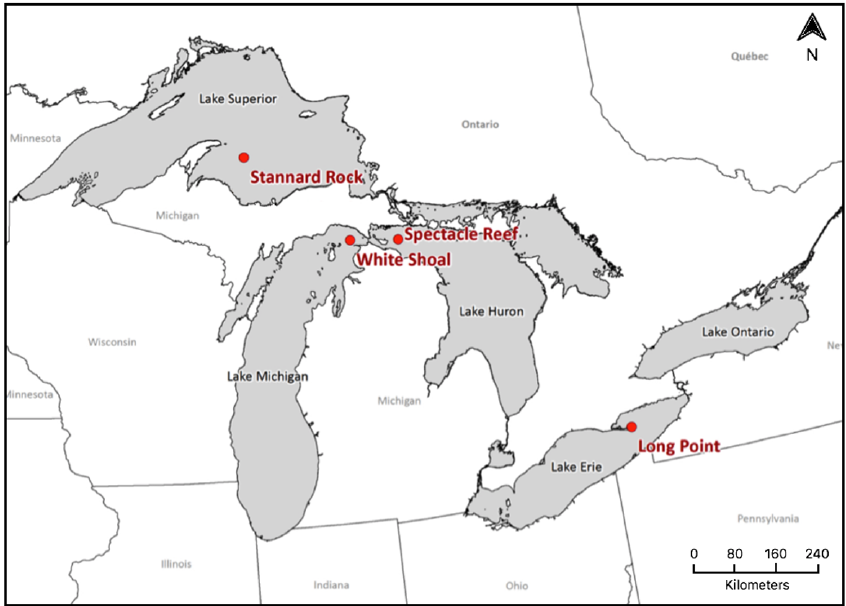
Figure 1. Map of the Laurentian Great Lakes, including the locations of offshore lighthouse-based monitoring stations used in this study. Map adapted from Lenters et al. (2013). Instrument heights above the mean water level are 39.0m at Stannard Rock, 29.5m at Long Point, 30.0m at Spectacle Reef, and 42.8m at White